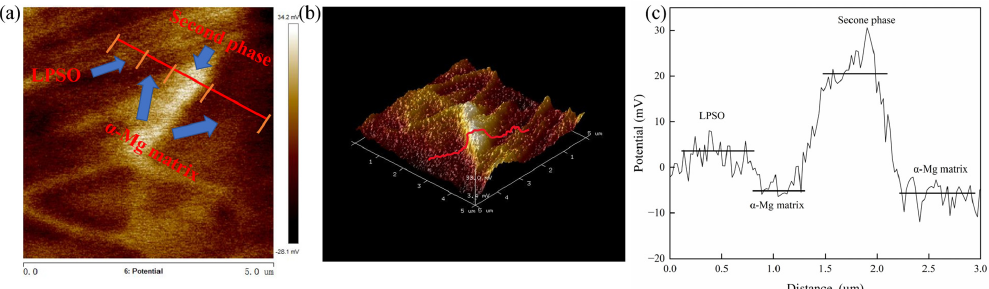
Figure 8. Volt potential distribution of as-aged alloy: ( a ) two-dimensional volt potential distribution, ( b ) three-dimensional volt potential distribution, ( c ) volt potential distribution of the selected line.